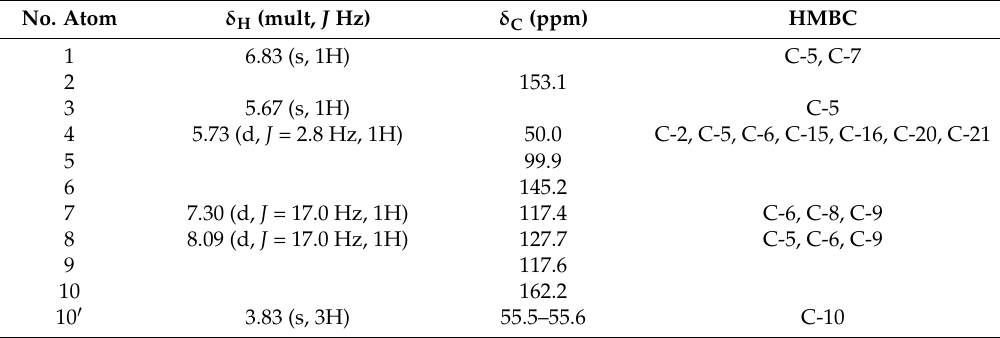
Table 1. NMR data of compound 2 in CDCl 3